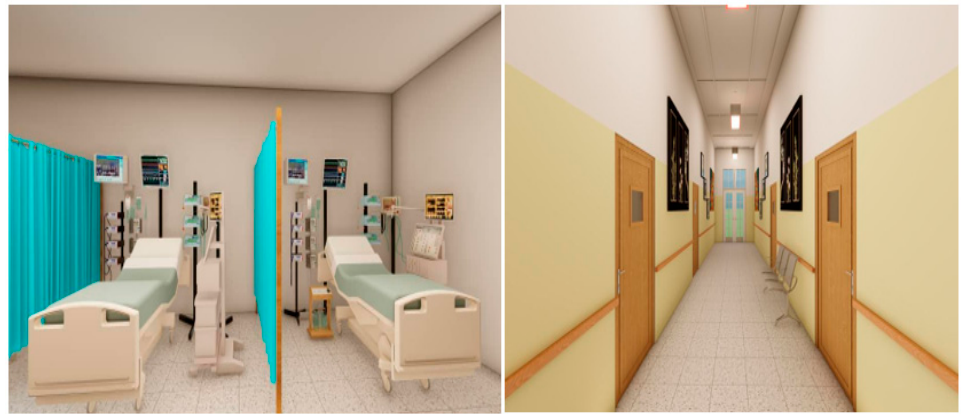
Figure 10. A pictorial representation of the ICU corridor rooms with some solutions